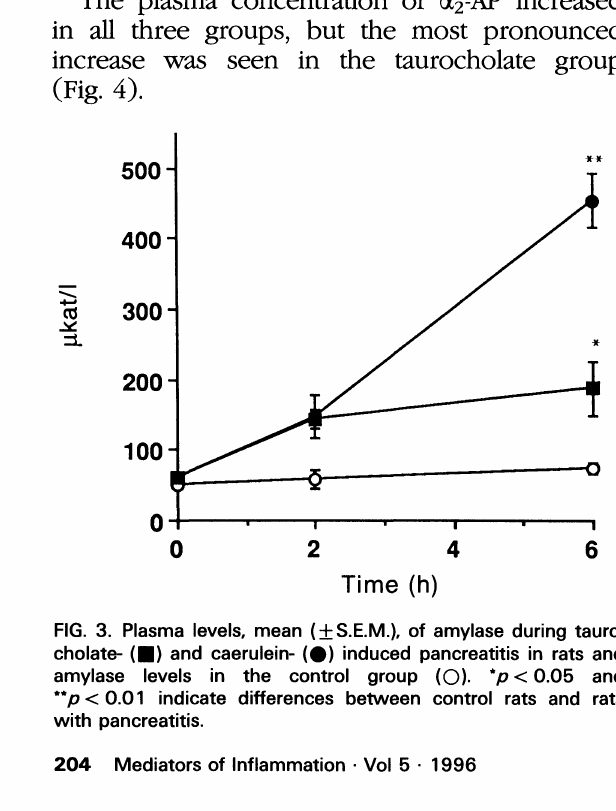
FIG. 3. Plasma levels, mean (___ S.E.M.), of amylase during tauro- cholate- (,) and caerulein- (I)) induced pancreatitis in rats and amylase levels in the control group (O). *p<0.05 and **p < 0.01 indicate differences between control rats and rats with pancreatitis.